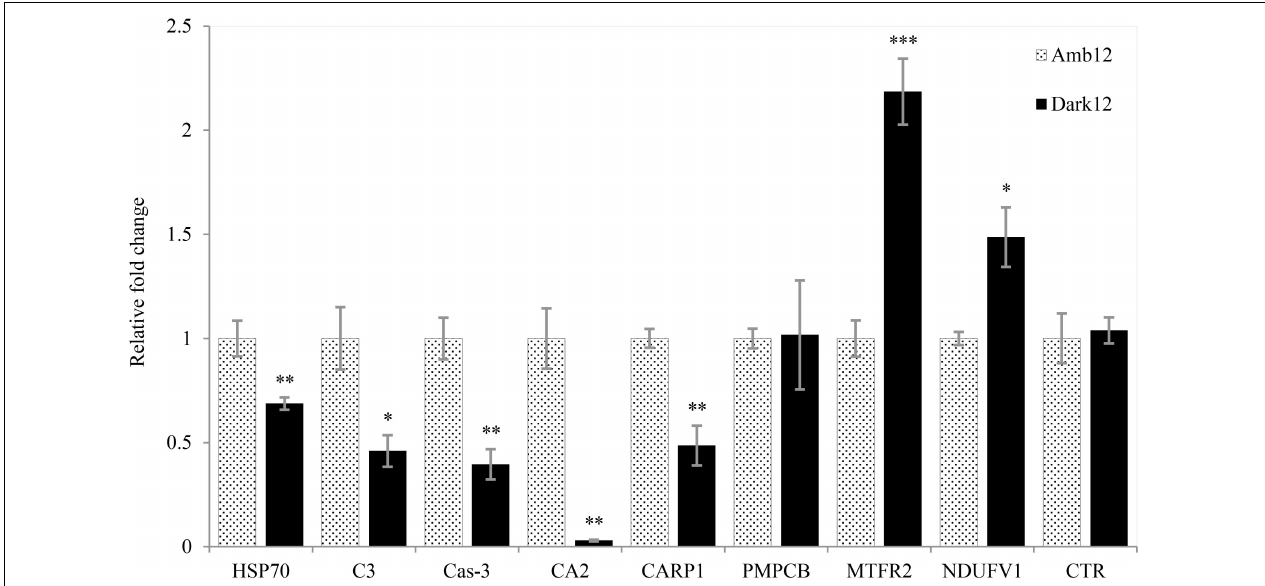
FIGURE 8 | Relative fold change of real-time qPCR. Mean ( ± SE) Gene expression results for the dark (Black bars) and ambient-light (light bars) samples at the 12-month time point using the gene comparative C T method. The relative fold change was calculated based on the ambient-light samples data. Independent sample t -test. ∗ p < 0.05; ∗∗ p < 0.01; ∗∗∗ p < 0.001 ( N =